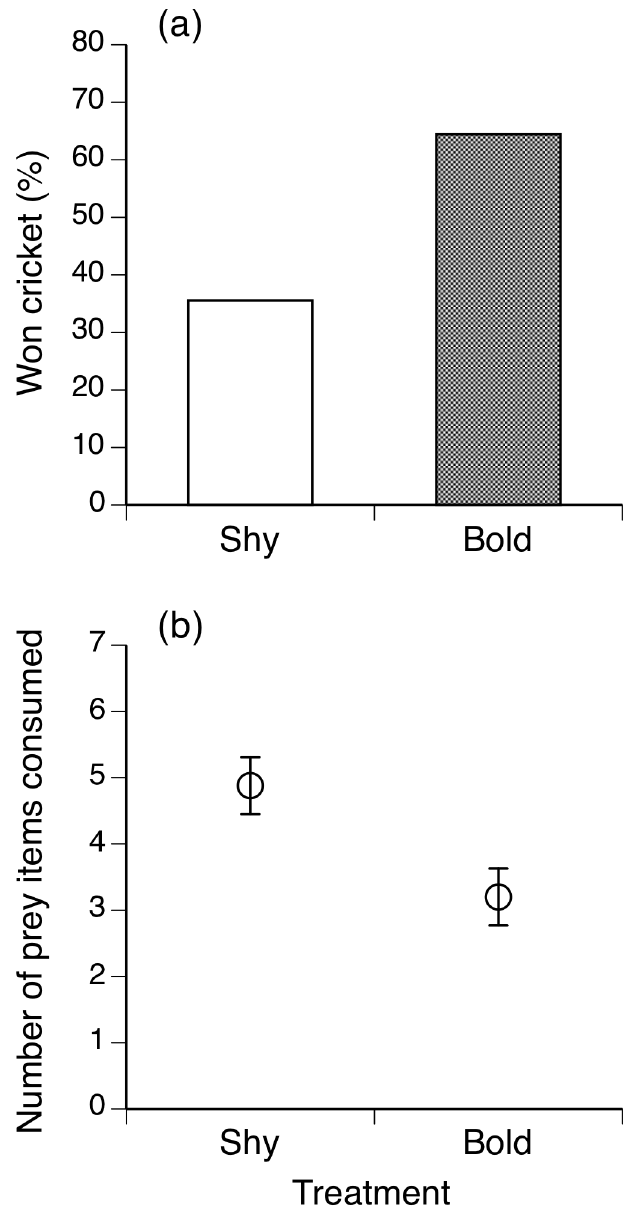
Figure 3. Foraging differences between ‘asocial-bold’ and ‘social-shy’ cane toads. Comparisons between ‘asocial-bold’ and ‘social-shy’ toads (classified based upon their responses to social cues in prior field trials) in terms of their foraging behaviour in standardized contests in the laboratory. When only a single cricket was available, the bolder individual was more likely to obtain that item (upper panel), but when multiple prey items (crickets) were available, shy toads ate more than bold toads (lower panel). The graphs show mean values and associated standard errors. bold individuals in a foraging situation, showing that personality affects scrounging behaviour. In this case, bold geese led while shy geese, by using social information, followed [42]. Bold behaviour allows individuals to be more exploratory and to take higher risks to locate and exploit potential foraging sites. In this sense, bold cane toads play a role as finders (producers in the producer- scrounge game) by detecting rich foraging patches while shy toads